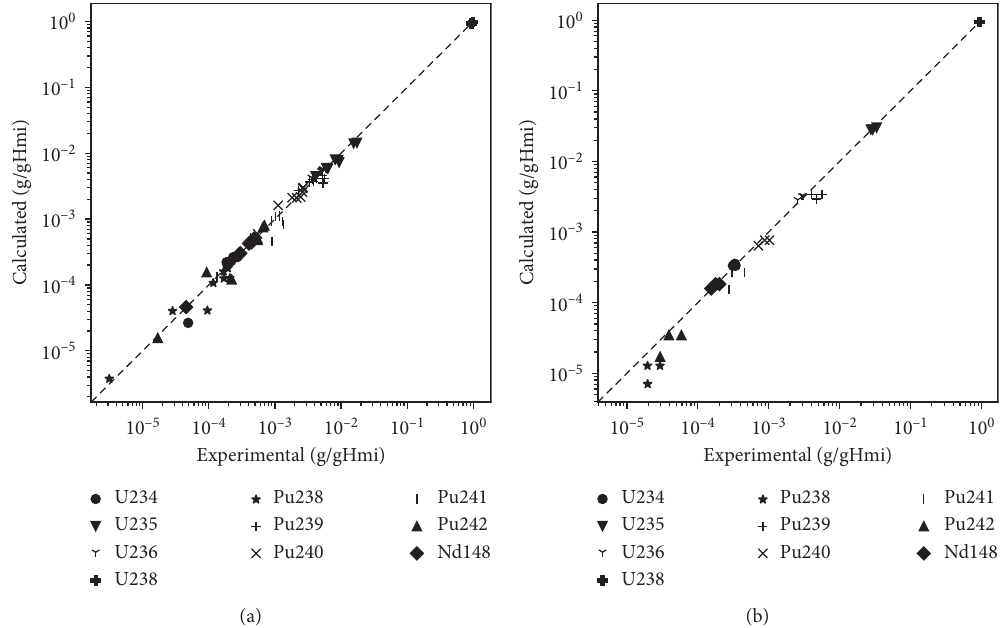
Figure 11: Validation of selected spent fuel isotopics in 2F2DN23/SF98 (a) and 2F2D1/F6